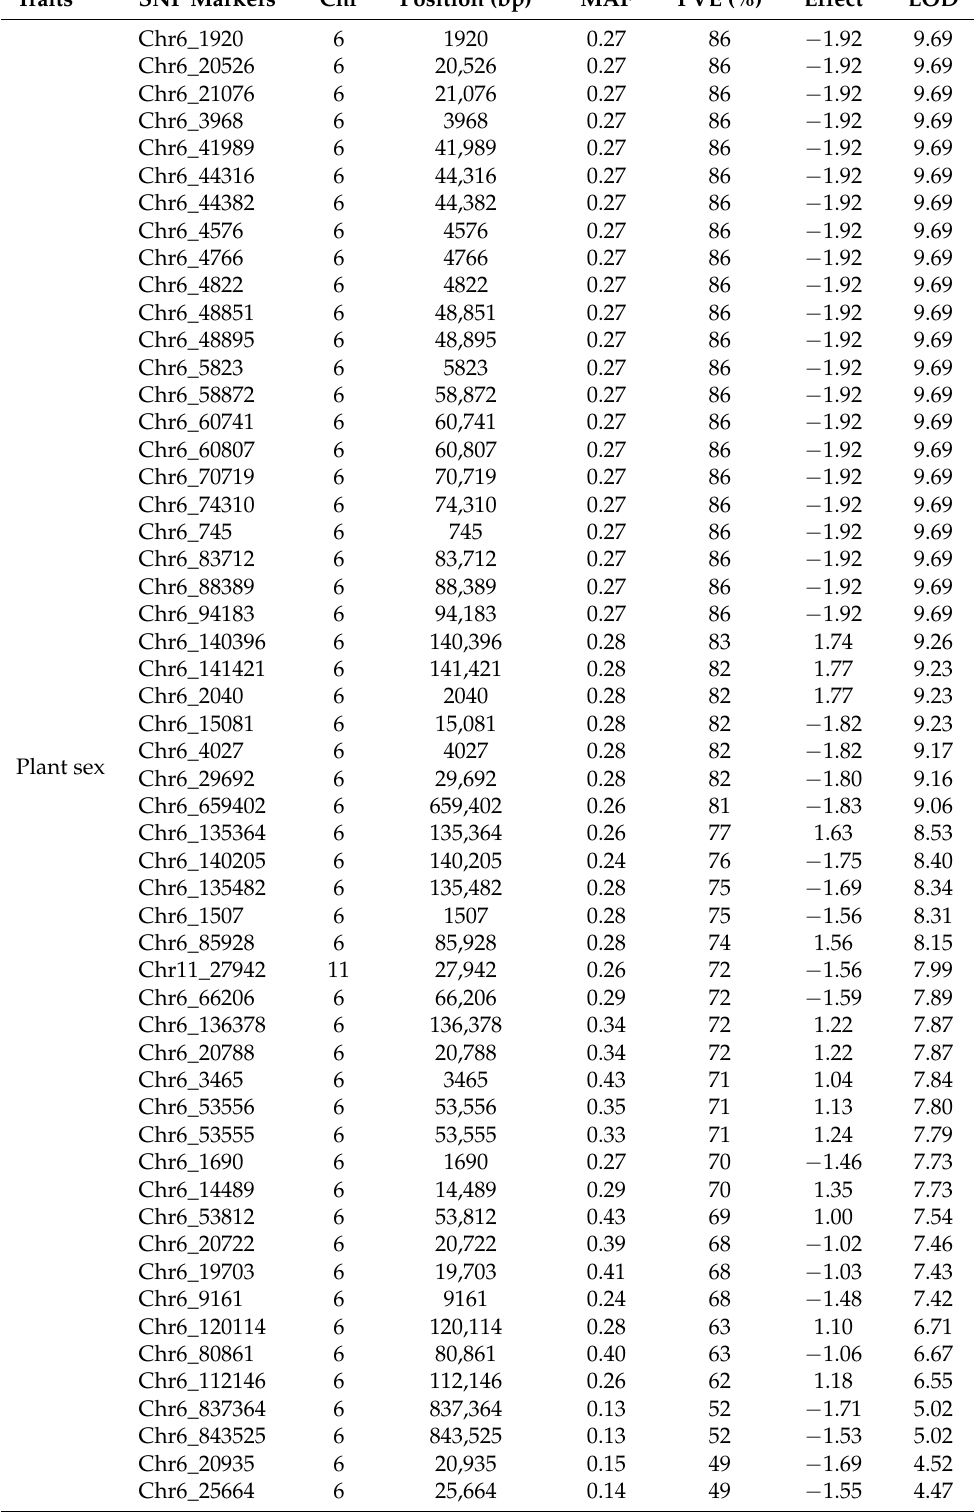
Table 2. Loci associated with sex identity, average crossability rate (ACR) and percentage high crossability (PHC) in D. alata. Markers are arranged in declining LOD values for plant sex and by chromosomes for ACR and